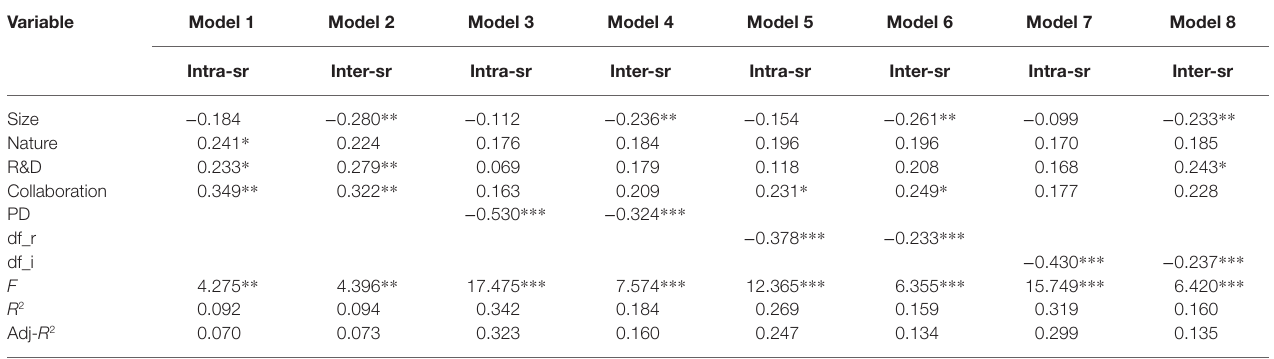
TABLE 4 | Results of the direct relationship between psychological distance, divisive faultlines and technological innovation network subgroup reciprocity ( N =